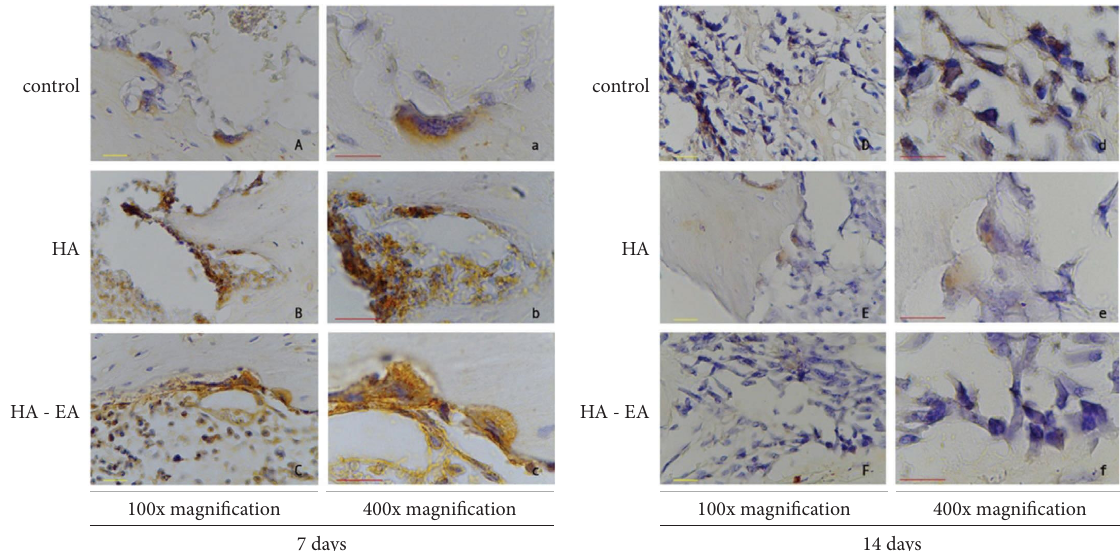
Figure 1: TNF- α expression in bone tissue 7 days after application (a, b, and c) and 14 days after application (d, e, and f). Te TNF- α expression was expressed in macrophages as brown colour in